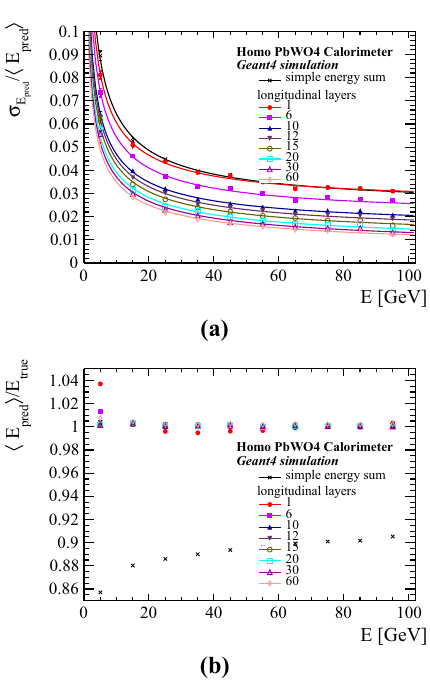
value at a cell size of ≈ 1 λ π , and finer segmentation does not yield any appreciable further benefit. In the